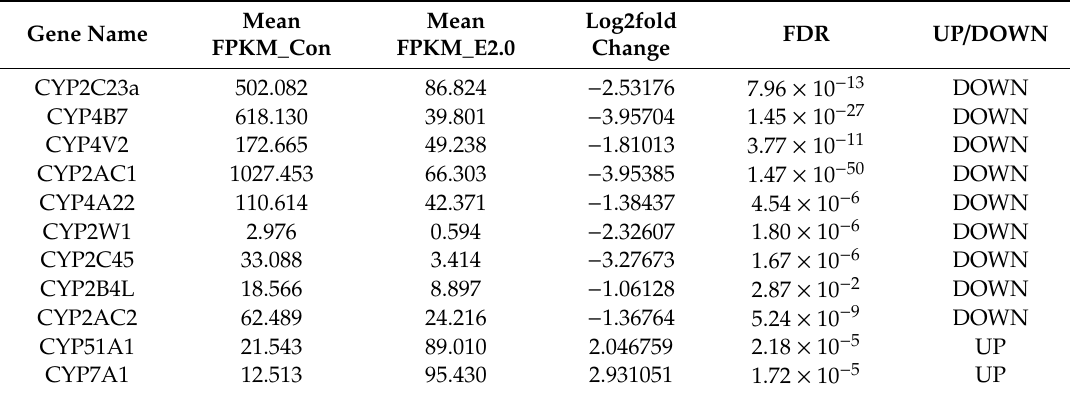
Table 2. Estrogen-responsive cCYPs in chicken